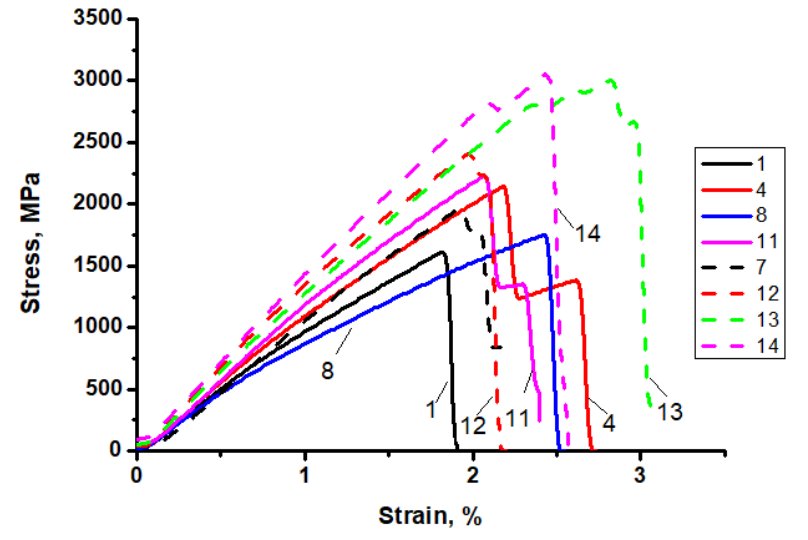
Figure 7. Stress-elongation curves for UHMWPE orientated tapes (Tables 1 and 2, entries 1,4,7,8, 11 – 14).